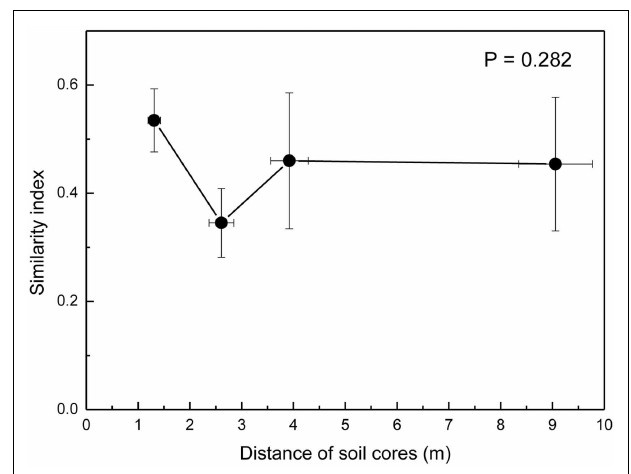
FIGURE 5 | Morisita–Horn similarity indices of ectomycorrhizal assemblages calculated for pairs of soil cores at increasing distance from each other. 1.3m = neighboring cores, 2.6m = every second core (e.g., A1_A3, A2_M, B1_B3, etc), 3.8m = every third core (e.g., A1_M,